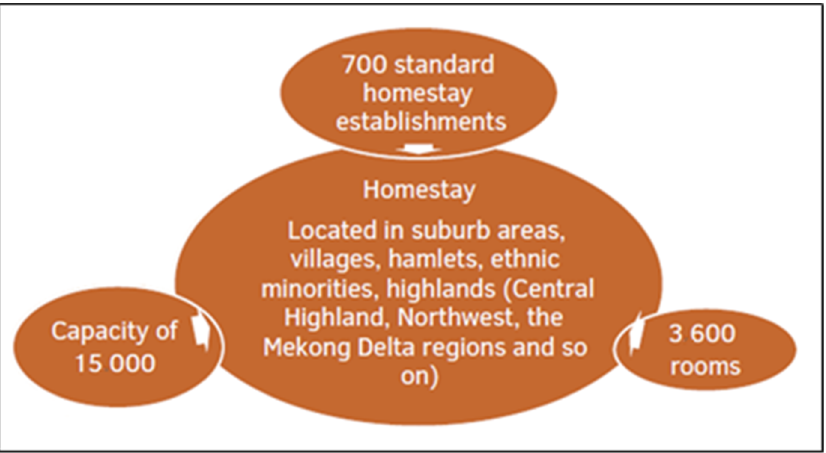
Figure 1. CBT/homestay in Vietnam. Source: (VNAT 2015, p. 38).